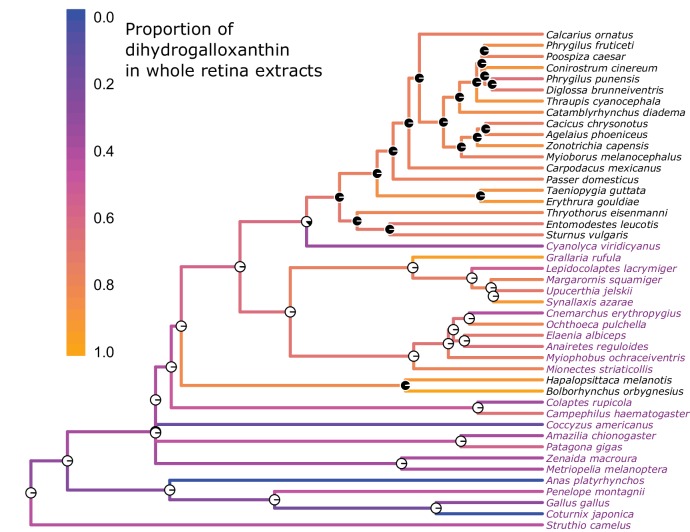
The evolution of the UV sensitive SWS1 opsin is associated with changes in whole retina apocarotenoid composition.The names of UVS species are written in black and those of VS species in purple. The color of each branch represents the proportion of dihydrogalloxanthin in the total apocarotenoid complement of the whole retina. The proportions of dihydrogalloxanthin for ancestral branches were estimated using maximum likelihood. The pie charts at each node indicate the maximum-likelihood ancestral state for the SWS1 opsin, with black and white indicating the probability of UVS and VS, respectively.